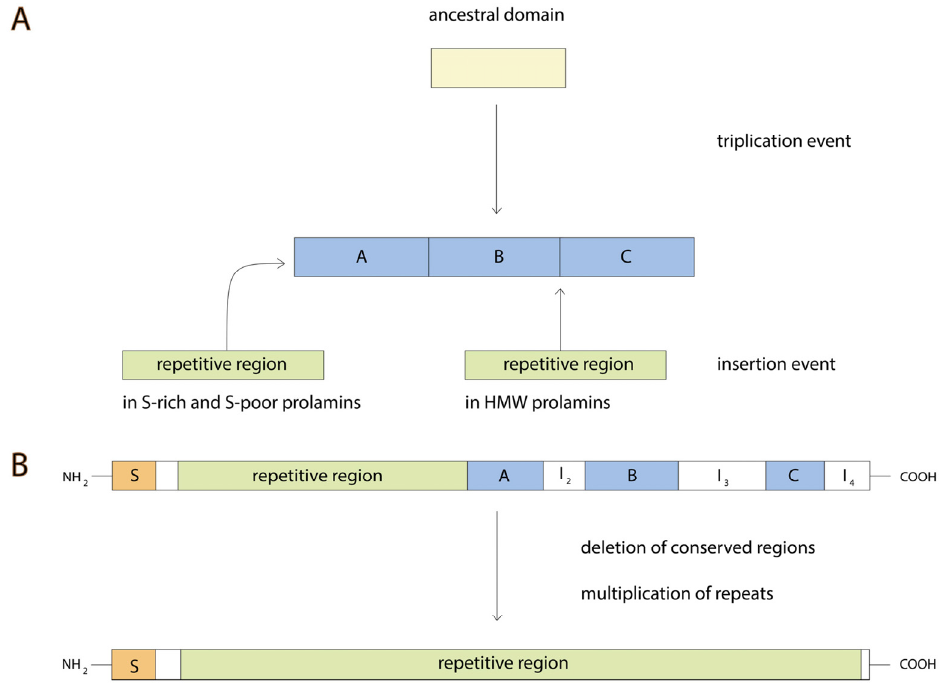
Figure 4. Summary of evolutionary events that probably contributed to the divergence of Prolamin Superfamily proteins. A, B, C—conserved regions, S—signal peptide, I 2 –I 4 —variant regions. ( A